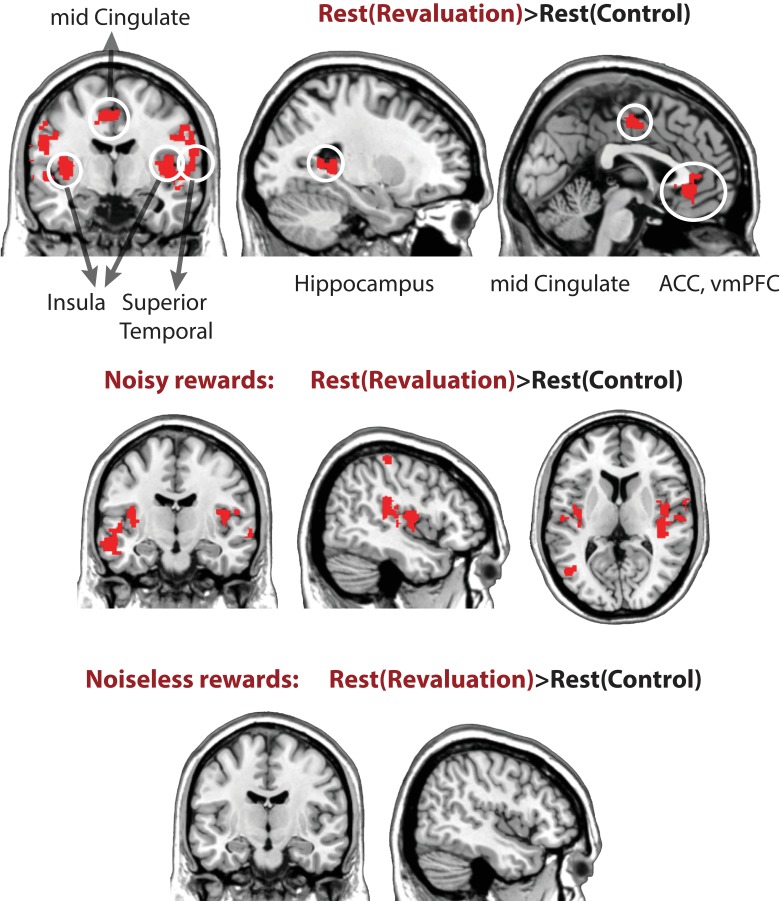
Univariate general linear model contrasts comparing activity rest periods of revaluation vs. control blocks, Restrevaluation> Restcontrol.The contrast reveals higher activity in the hippocampus, the anterior cingulate cortex, mid cingulate (shown above), as well as bilateral insula and superior temporal cortices (extent threshold p < 0.005, cluster level family-wise error corrected at p < 0.05). See Table 3 for coordinates, cluster size, and p values.